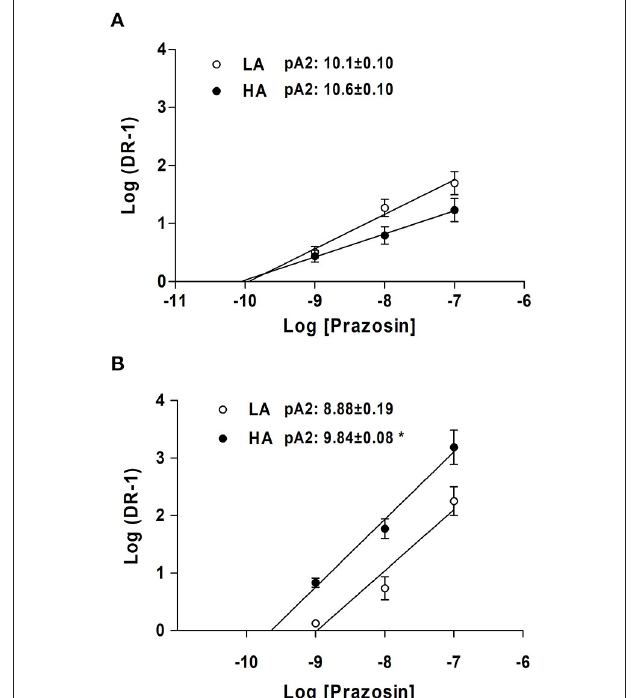
FIGURE 2 | Relative affinity (pA 2 ) in NBLL and NBSH of LA and HA obtained from concentration response curves to NA and NA in the presence of prazosin at 1, 10, and 100nM and Schild plots analysis. (A) NBLL at LA vs HA and (B) NB sheep. Values are expressed as means ± SEM. Asterisk (*) represent a significant difference between NBSH (LA/HA) ( p <